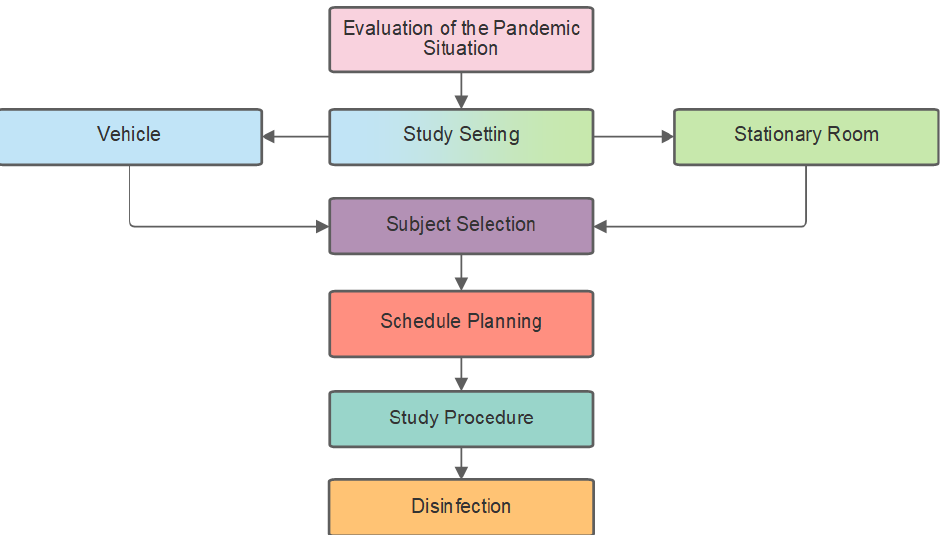
Figure 1. Holistic concept for infection prevention in studies conducted in stationary rooms and vehicles.